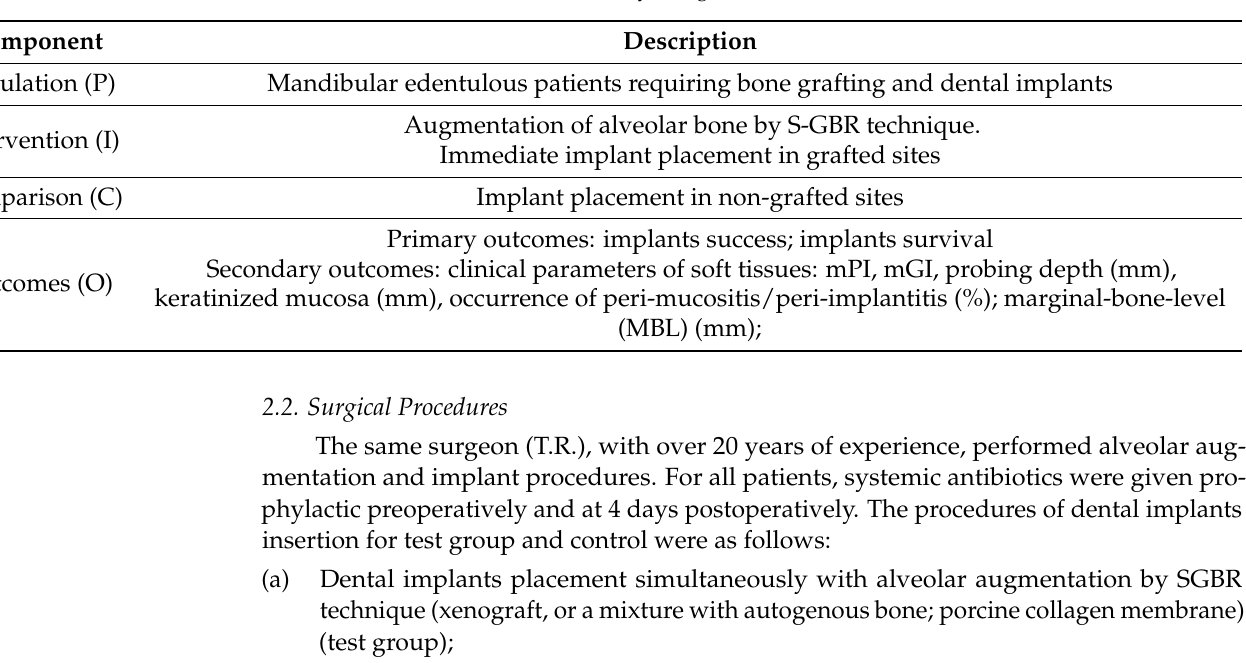
Table 2. PICO study